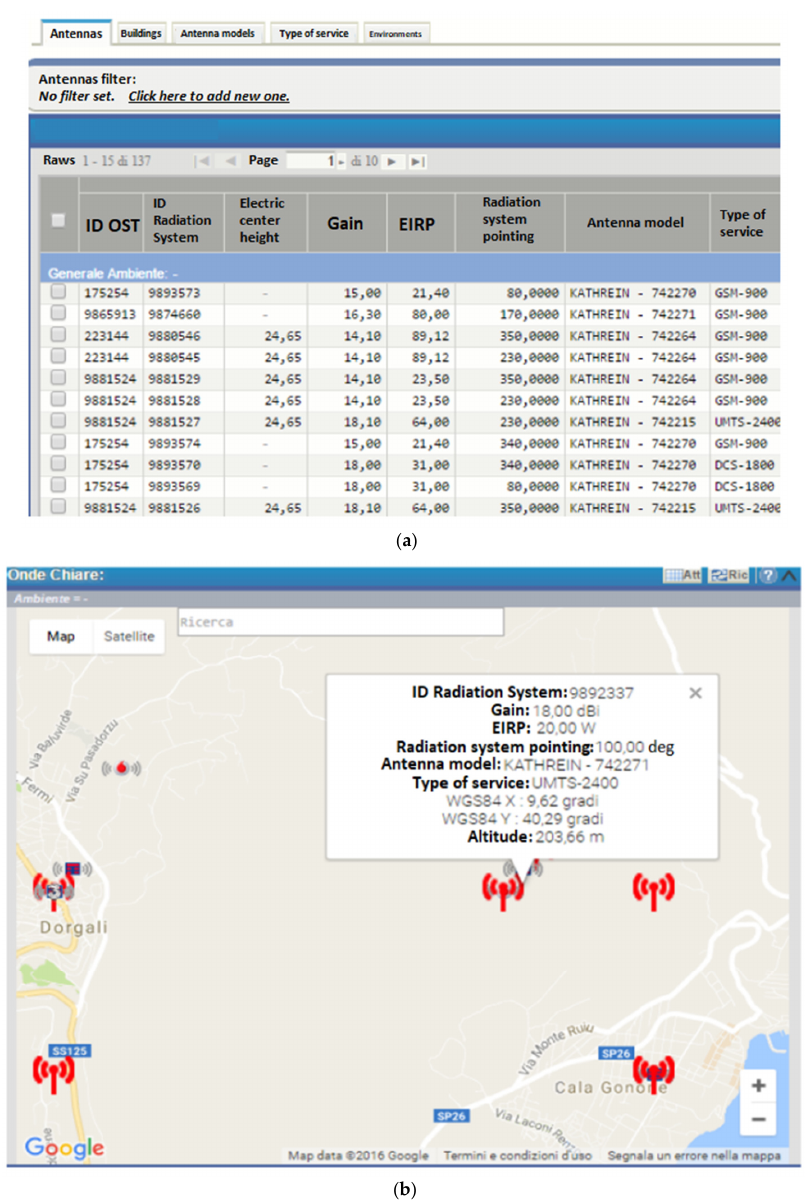
Figure 3. General scheme for the Onde Chiare system. The user can access the database, using an Android device, to check geolocalized information in order to recover the set of surrounding RBSs. The server elaborates the electric field estimation using the modified version of the C231WI model with the geographical and topological data and then sends the output to the user.